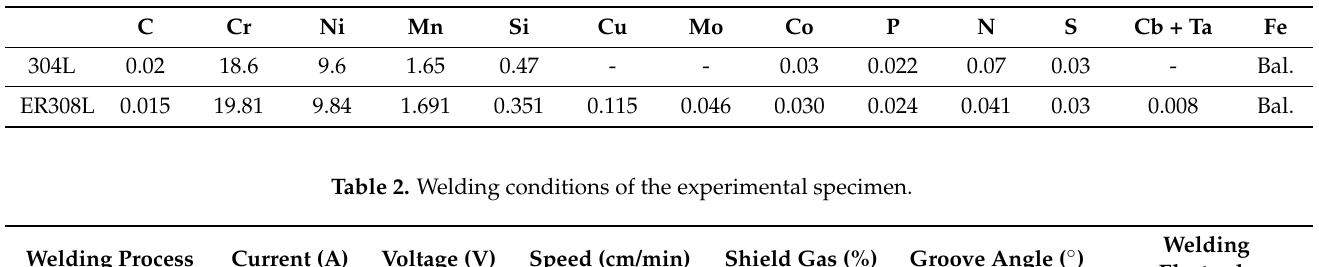
Table 1. Chemical composition of 304L stainless steel and filler metal (wt %).